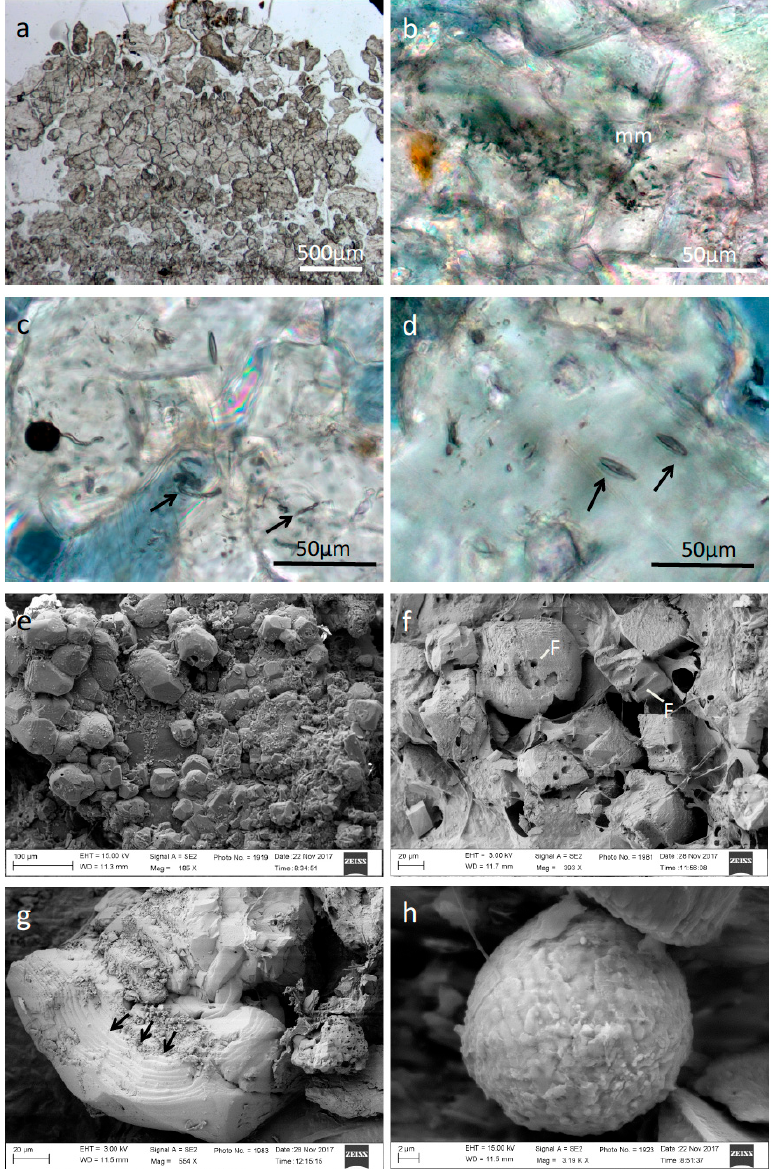
Figure 3. Microstructure of representative carbonate buildups from Torrente Branega: ( a ) Aggregates of grey calcites. Stromatolitic crusts are just weakly developed. ( b ) Microbial mat remains (mm) entrapped in calcites. ( c ) Filamentous microbial remains (arrows) within calcite crystals. ( d ) Pennate diatoms entrapped within calcite (arrows). ( e ) FE-SEM picture of newly formed anhedral calcite crystals. ( f ) FE-SEM picture of nearly euhedral calcite crystals exhibiting holes of formerly filamentous microbes and remains. The crystals are covered by dehydrated exopolymeric substances (EPS). ( g ) FE-SEM picture of an anhedral calcite crystal showing “stromatolitic” growth pattern (arrows). ( h ) FE-SEM picture of a framboidal pyrite globule associated with